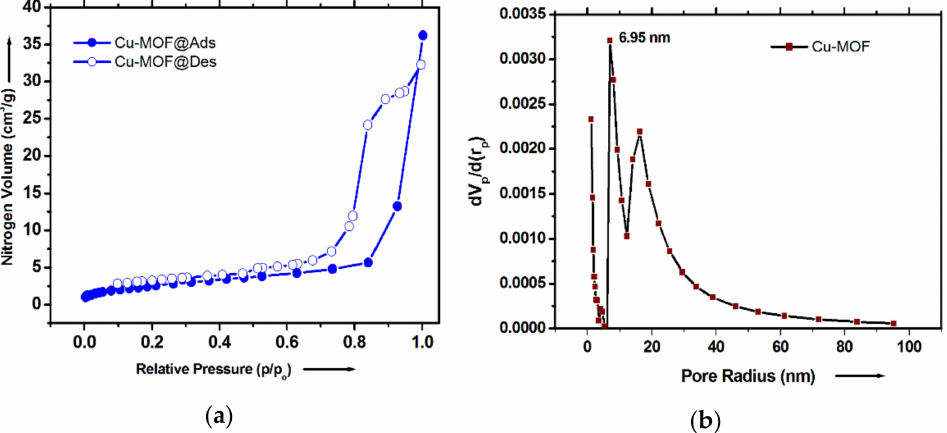
Figure 1. ( a ) N 2 adsorption isotherms for Cu-MOF at 77 K and ( b ) Howarth–Kawazoe (HK) pore-size distribution calculated from N 2 adsorption at 77 K for